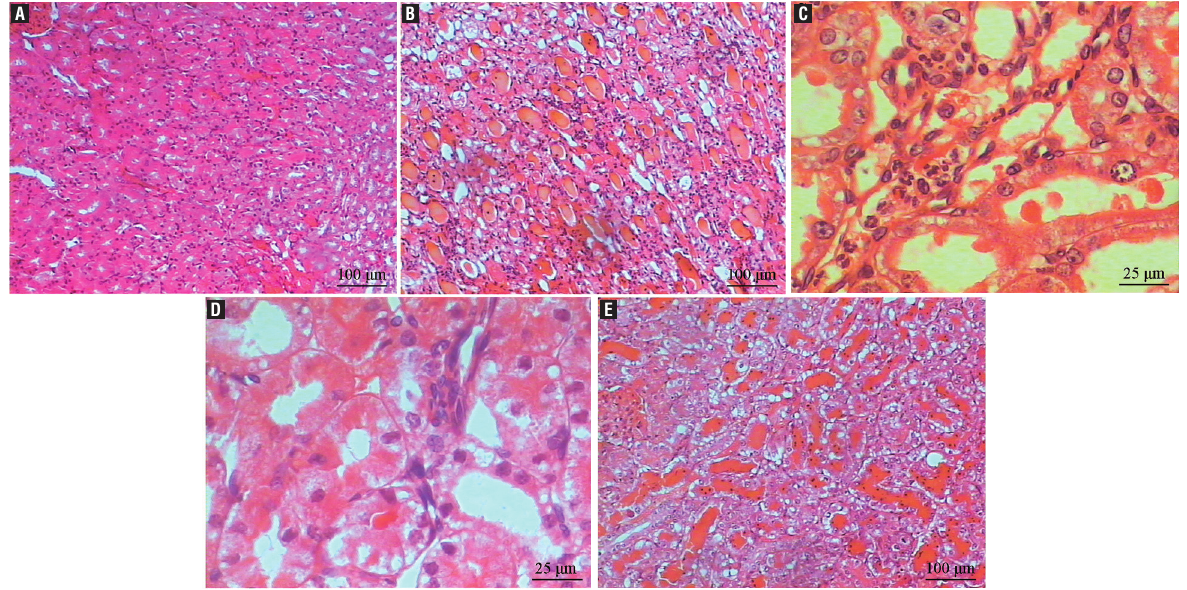
Figure 1 - HE staining of renal